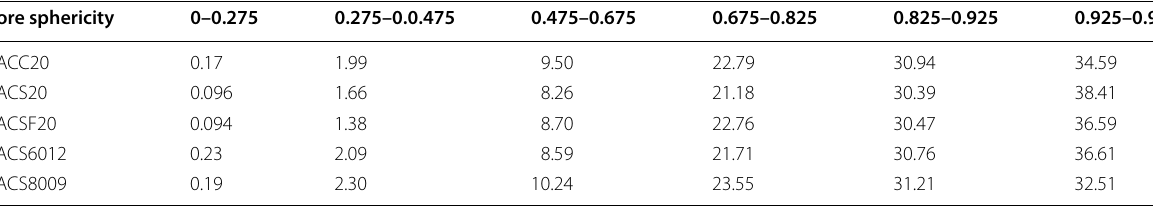
Table 6 Percentage value of pore sphericity in different ranges (%) Pore sphericity